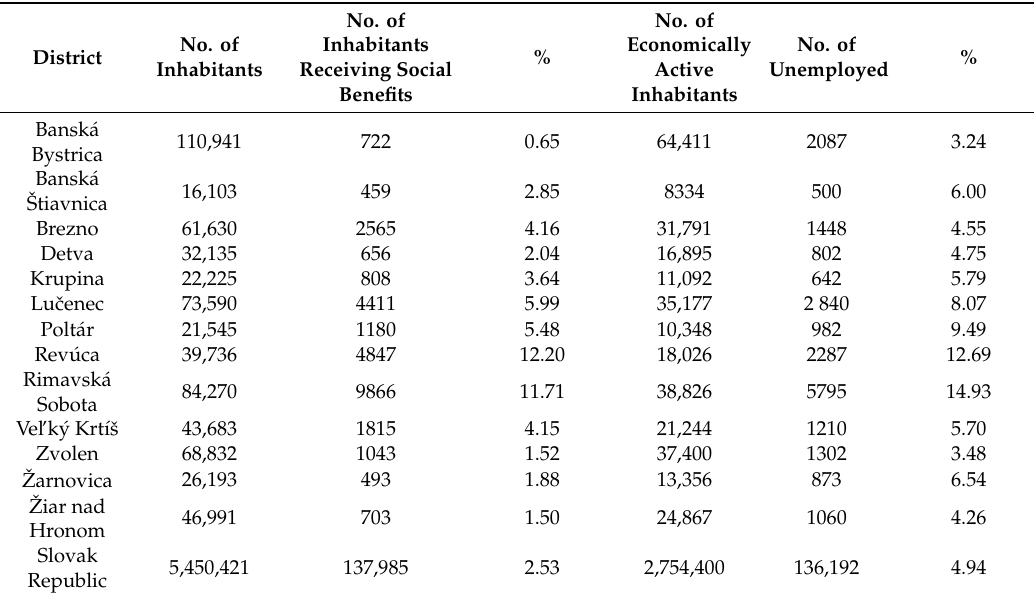
Table 3. The number of socially disadvantaged inhabitants per district in the Banskobystrick ý Self-governing Region (Source: